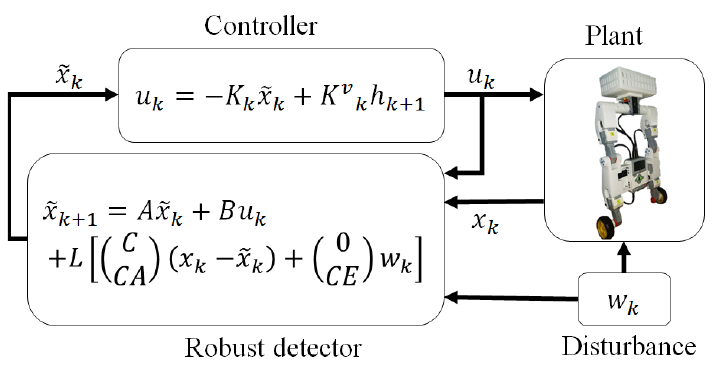
Figure 4. Implementation diagram.